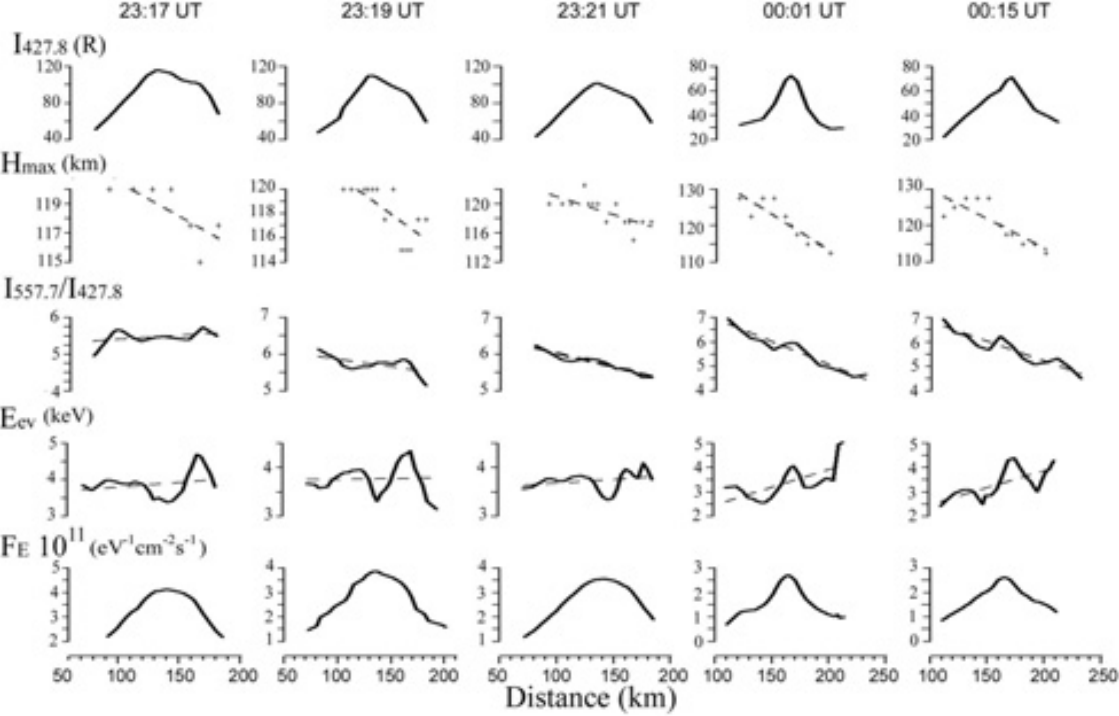
Fig. 6. Meridional variations of different auroral emission intensities and parameters of the precipitating electron flux inside the entire auroral formation.